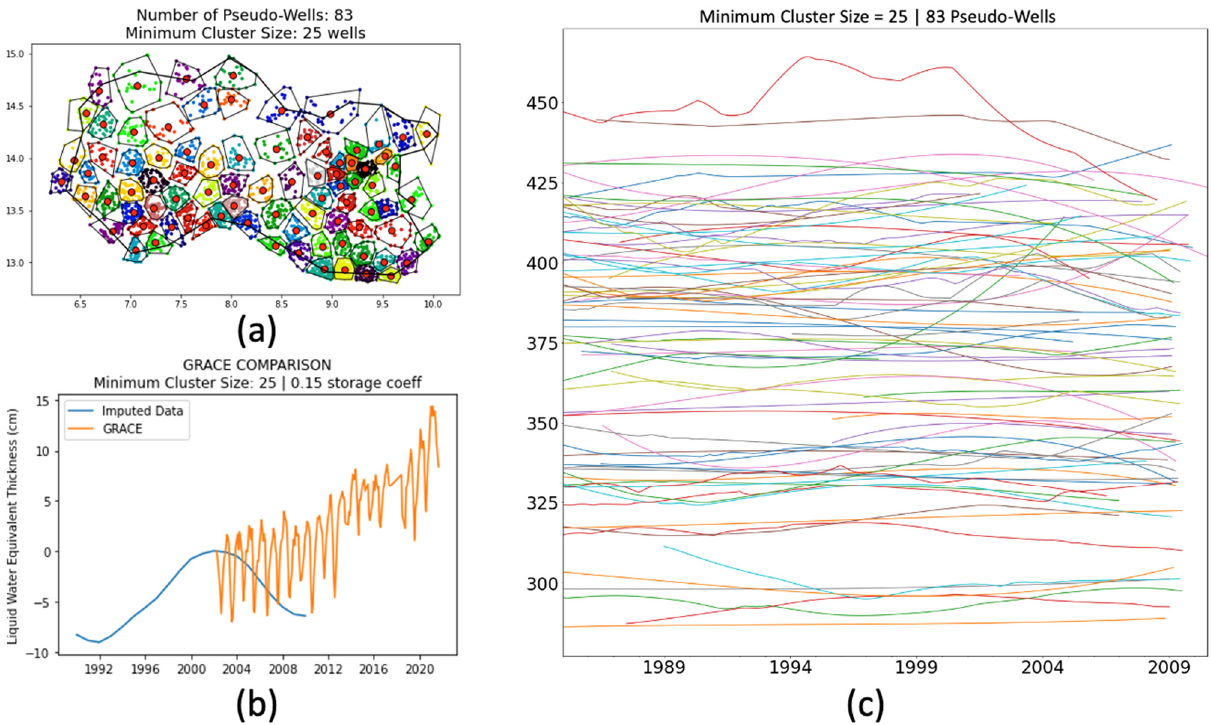
Figure A2. Using 0.25-degree square grid clustering, ( a ) spatial distribution of the pseudo-wells, ( b ) groundwater storage change comparison against the GGST GWSa, and ( c ) synthetic WTE time series of each pseudo-well.